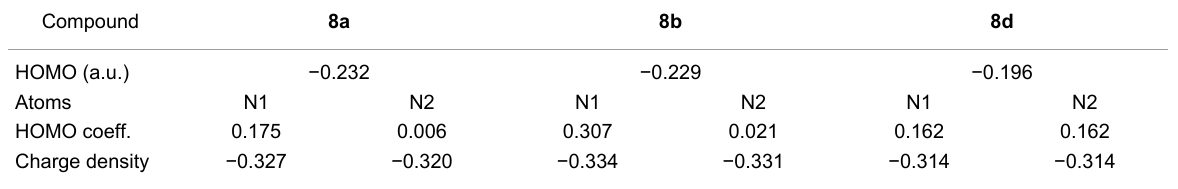
Table 7: HOMO coefficients and charge densities for the selected atoms in the precursors 8a–f obtained by DFT-B3LYP calculations. Compound 8a 8b 8d HOMO (a.u.) − 0.232 − 0.229 Atoms N1 N2 N1 N2 N1 N2 HOMO coeff.